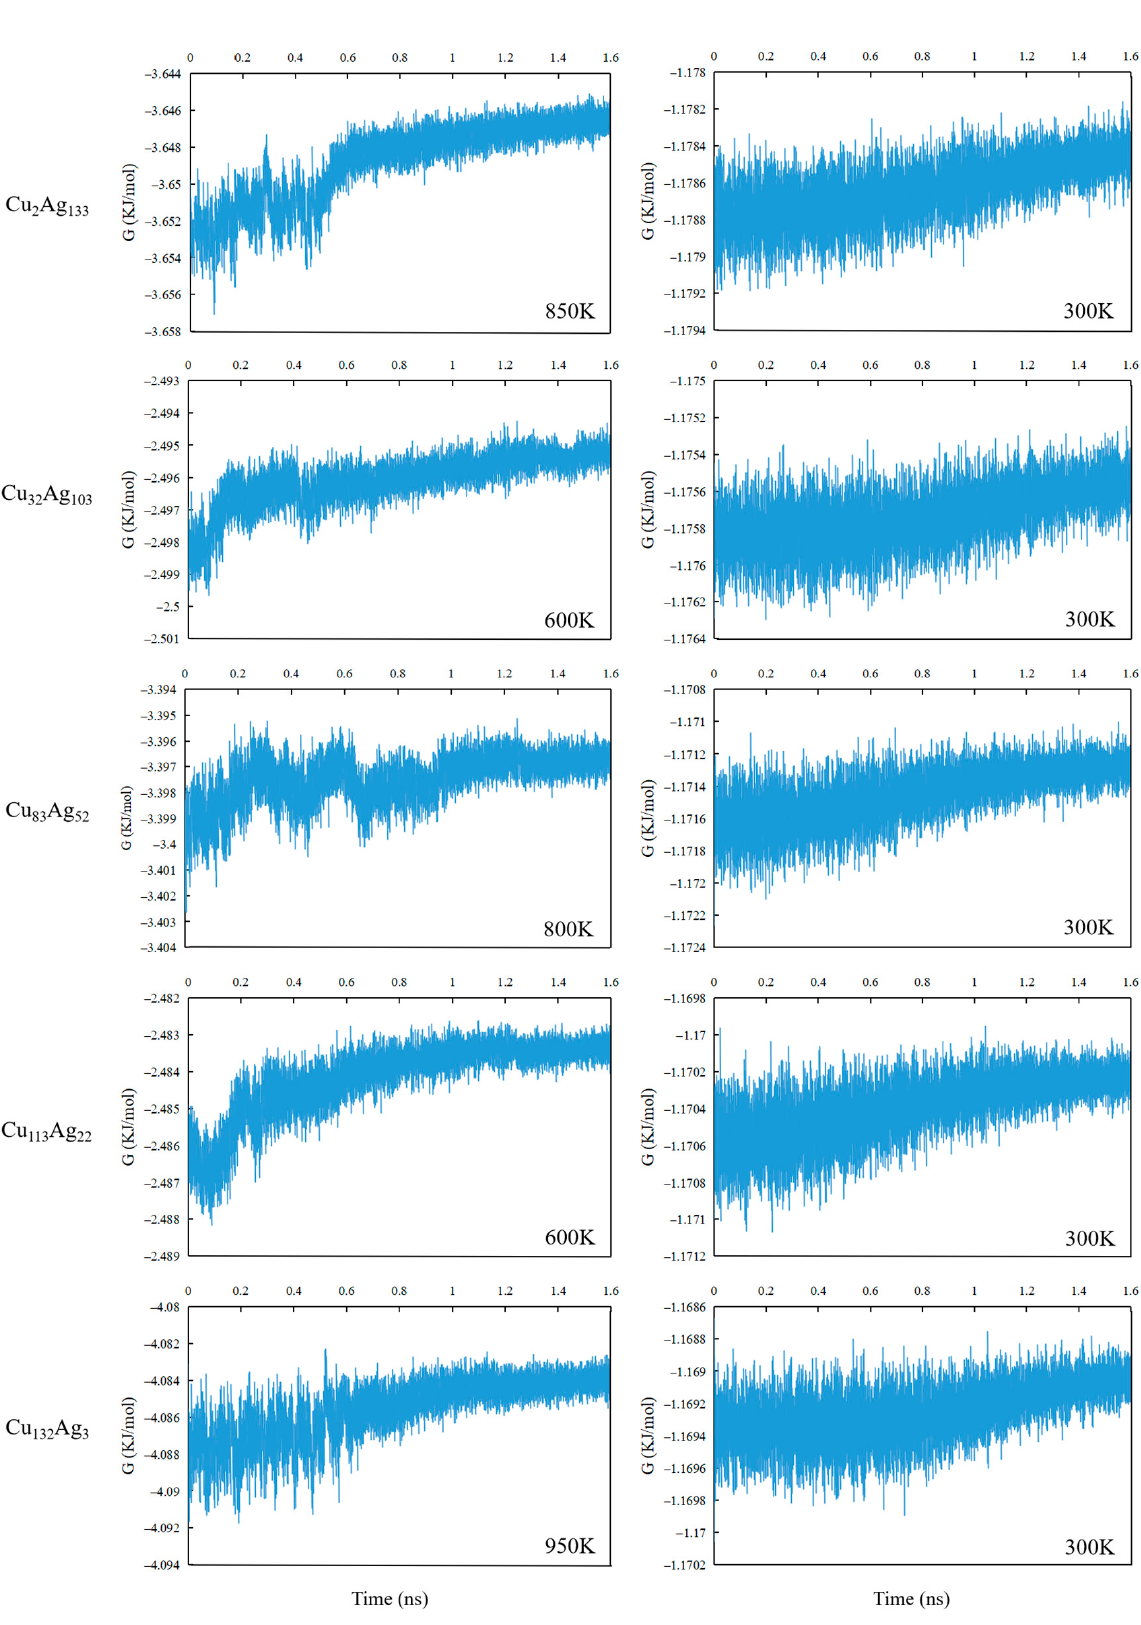
Figure 7. Free energy variation of five clusters with time.